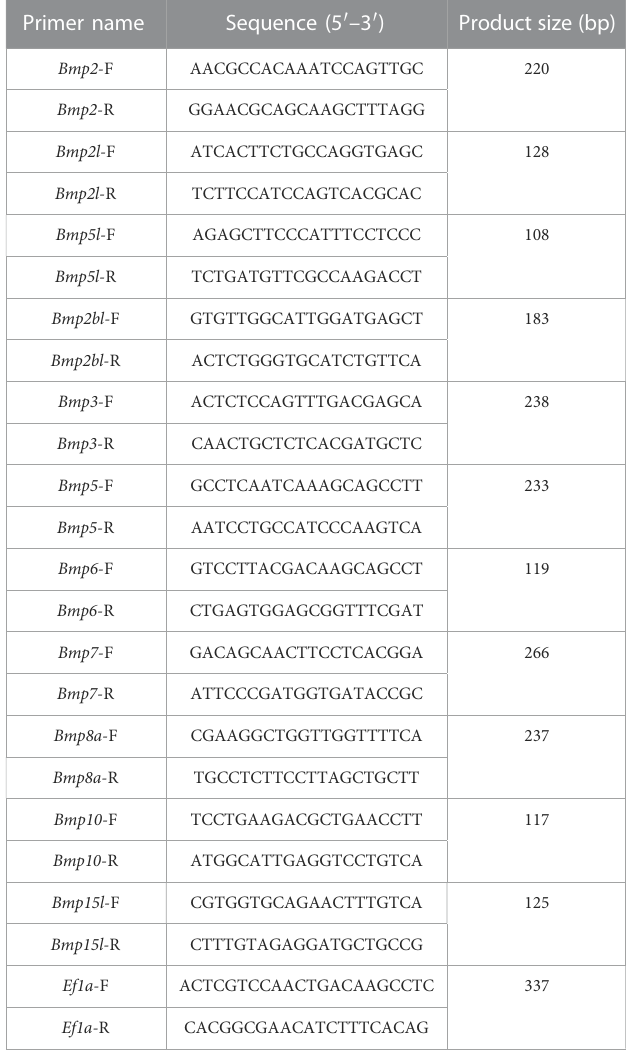
TABLE 1 The primers sequences of